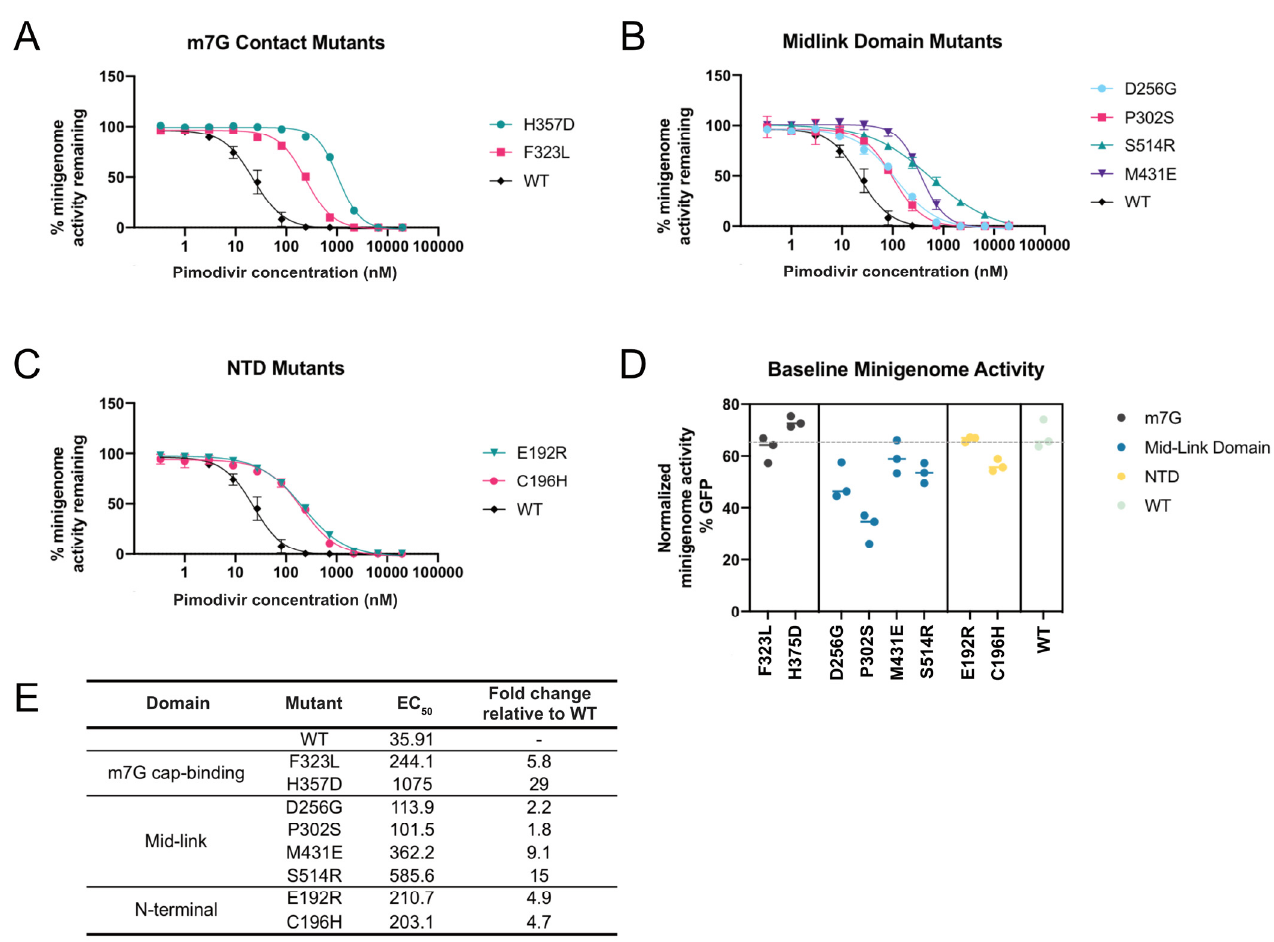
Figure 3. Validation of pimodivir resistance mutations using a minigenome assay. The indicated mutations were all made in the background of PB2-S009 with the E627K human-adaptive mutation. Hence, the “wildtype control”, “WT”, refers to PB2 that already has the E627K mutation. ( A – C ) Minigenome activity curves were plotted based on minigenome activity at various pimodivir concentrations, normalized to activity in the absence of pimodivir. ( D ) Minigenome activity was measured for polymerases containing each of the mutations, in the absence of pimodivir. ( E ) EC 50 and fold-change in EC 50 relative to wildtype, determined from the fit four-parameter logistic curves.